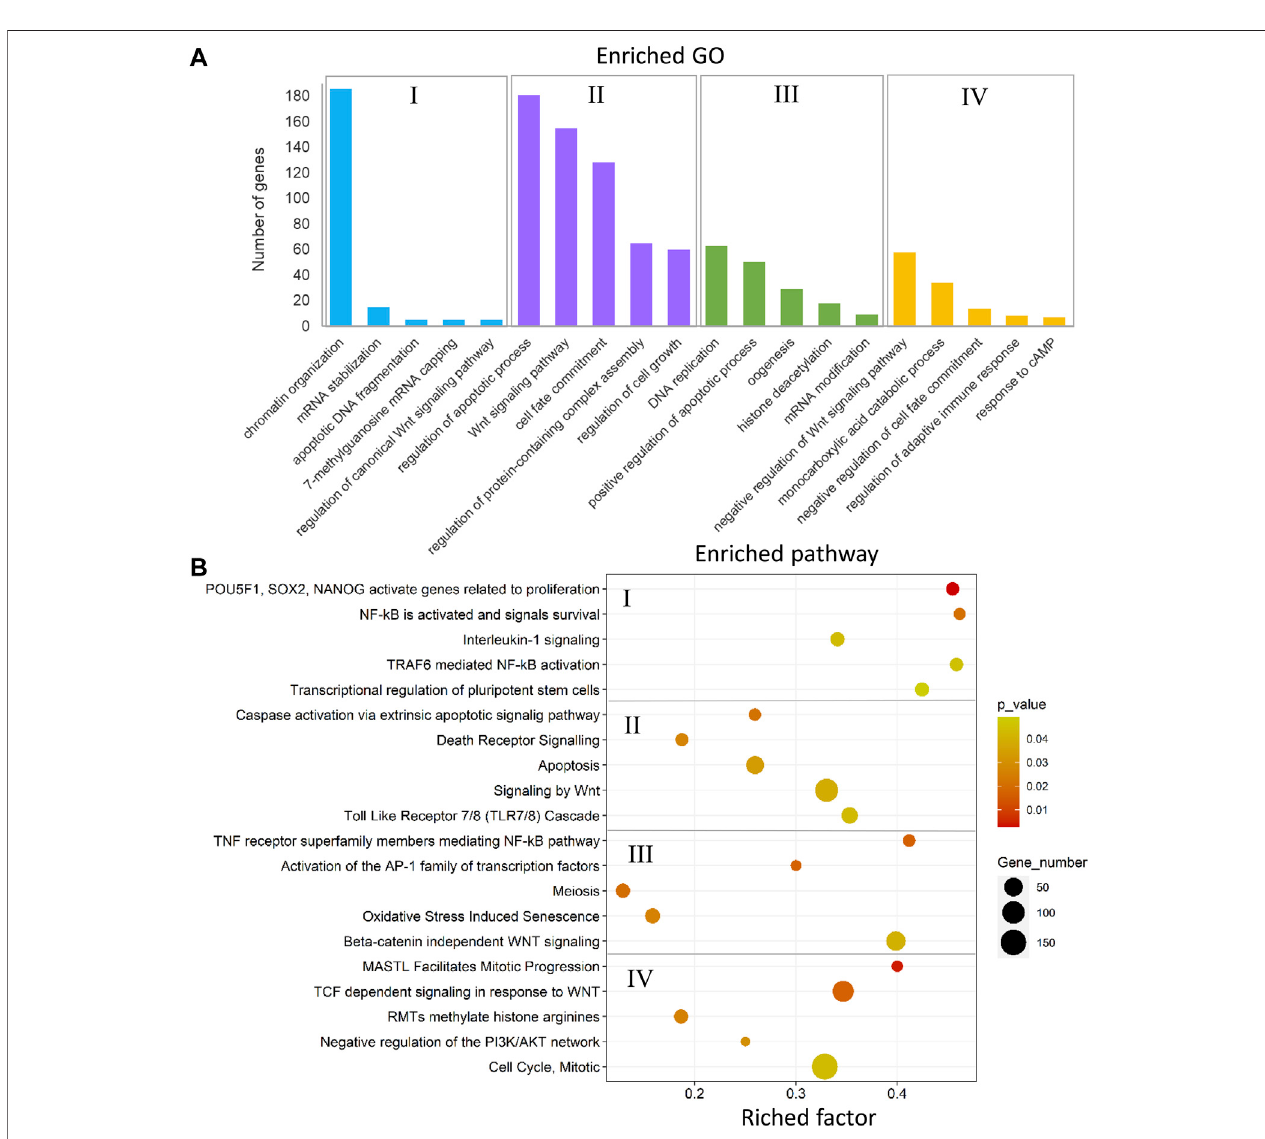
FIGURE12| Enriched GOsandpathwaysintestesversusovaries.TheresultsofbiologicalfunctionalannotationanalysisofgenesassociatedwithDMCs intestes versusovarieswithinmale-biasedandfemale-biasedfamiliesindifferentexperimentalgroups:(I)malecontrolmale-biasedversusfemalecontrolmale-biased(MCMBvs. FCMB); (II) male control female-biased versus female control female-biased (MCFB vs. FCFB); (III) male treatment male-biased versus female treatment male-biased (MTMB vs. FTMB); (IV) male treatment female-biased versus female treatment female-biased (MTFB vs. FTFB). (A) Bar charts represent the signi fi cant enriched GOs( p < 0.05).TheverticalaxisrepresentsthemostimportantenrichedGOsandthehorizontalaxisrepresentsthenumberofsigni fi cantlydifferentiallymethylatedgenes in each GO term. (B) Scatter plots illustrate the signi fi cant enriched pathways ( p < 0.05). The vertical axis represents the enriched pathway categories and the horizontal axisrepresentstherichfactoroftheenriched pathways. Richfactoristheratioofdifferentiallymethylatedgenenumberenriched inthepathway tothetotalgenenumber in a certain pathway. The size and colour of dots represent the gene number and the range of p -values, respectively.